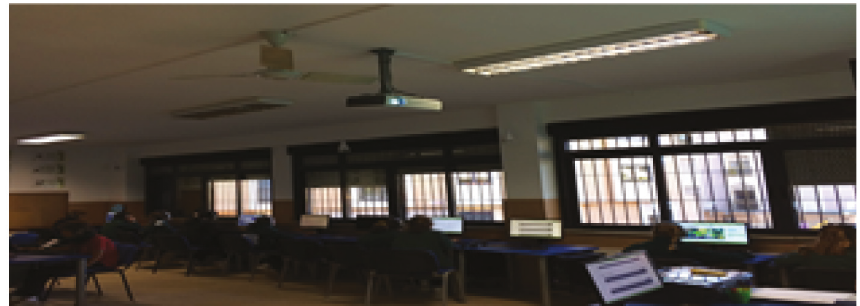
Figure 23: Children aged 11-12 years select relaxing video and audio in the second intervention (primary